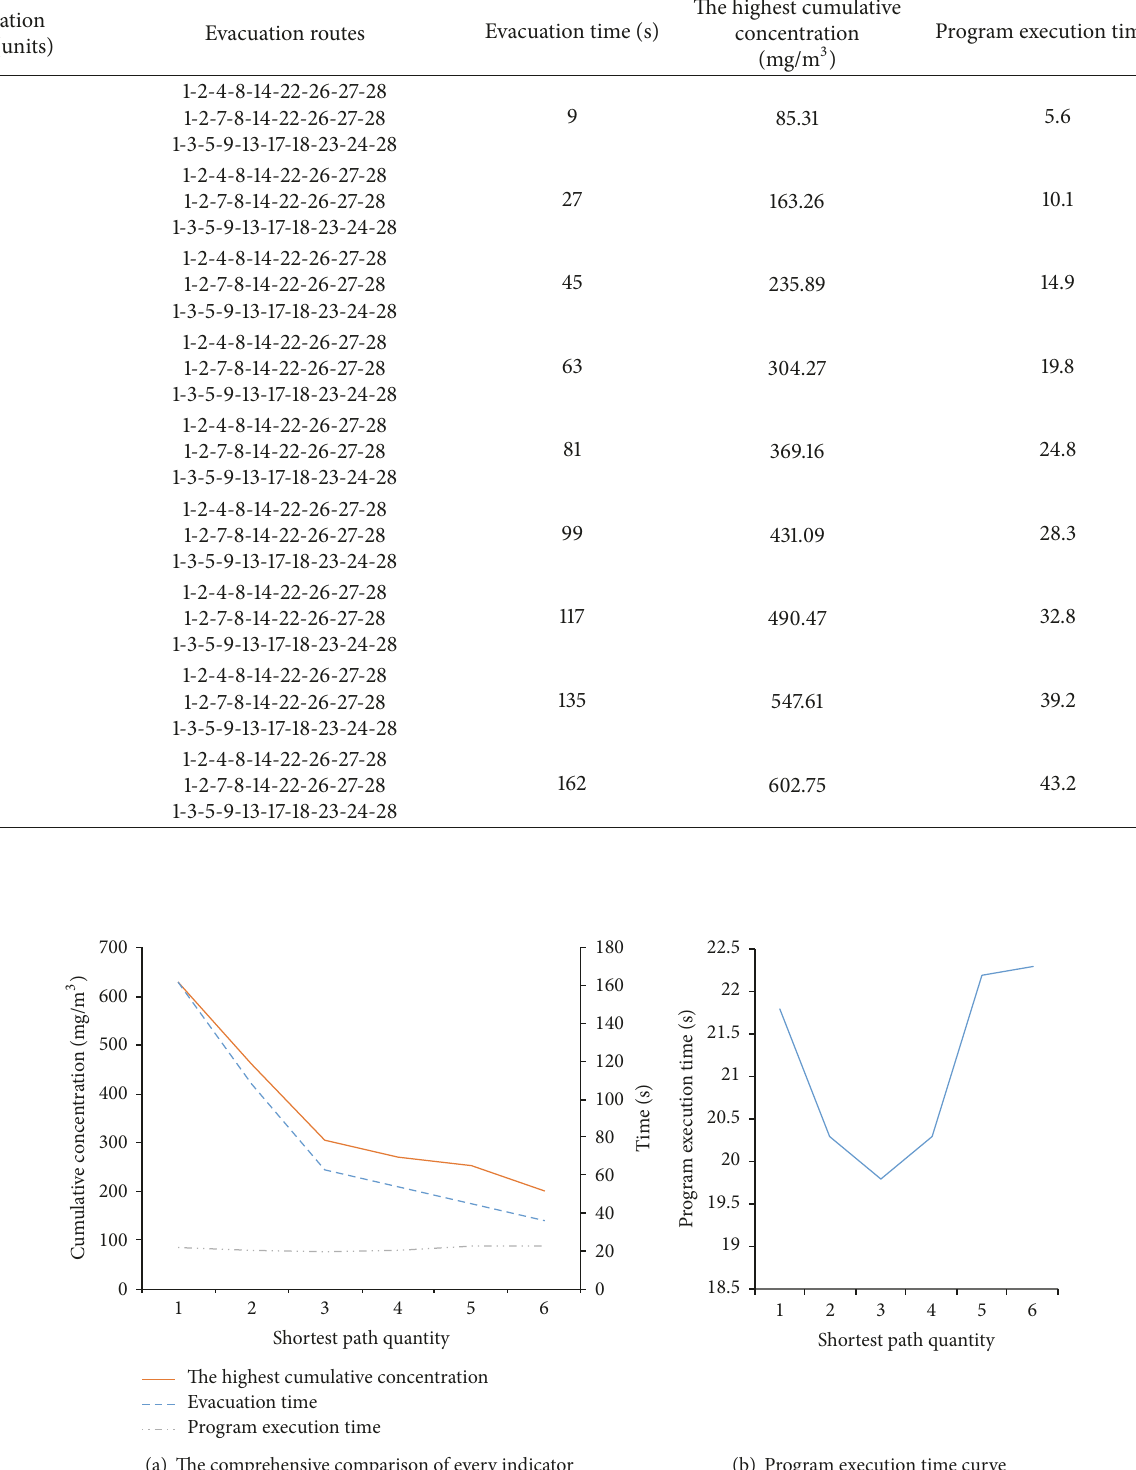
Table 3: The calculative results of different evacuation scales.